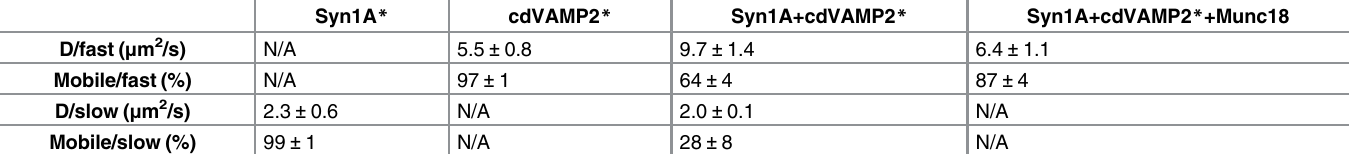
Table 3. Interaction parameters (diffusion coefficients and mobile fractions) of Syn1A and cdVAMP2 in a sponge phase, in the absence or pres- ence of Munc18-1. FITC-labeled molecules are indicated with a star. Two-sample t -tests on fast diffusion components: cdVAMP2 * vs. Syn1A+cdVAMP2